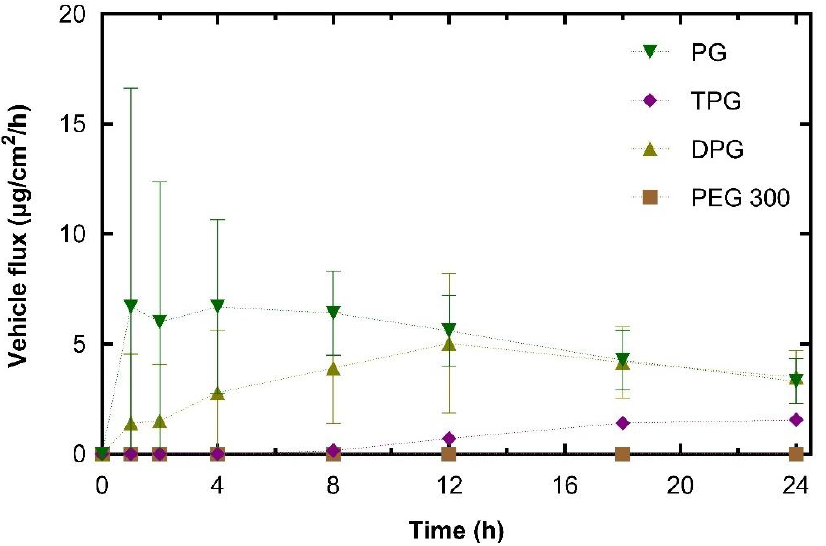
Figure 5. Estimated flux profiles for vehicles through human epidermis after application of samples (mean ± SD, n = 5).